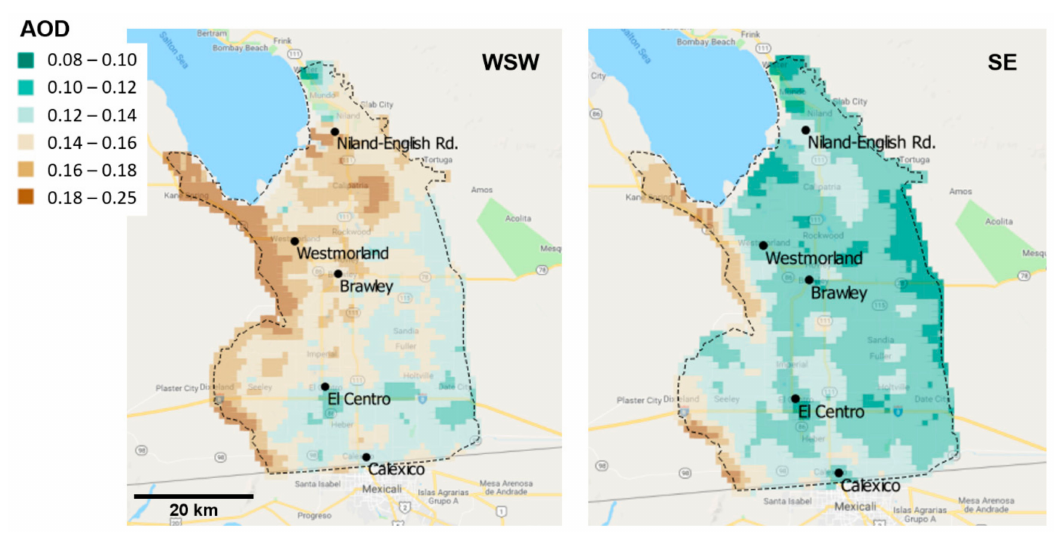
Figure 6. Average multi-angle implementation of atmospheric correction (MAIAC) aerosol optical depth (AOD) fields within the Imperial Valley ( dotted line ) for the WSW ( left ) and SE ( right ) sets. Fields constructed by averaging AOD fields over the cases comprising each respective set ( n = 31 for WSW, n = 47 for SE, see Table